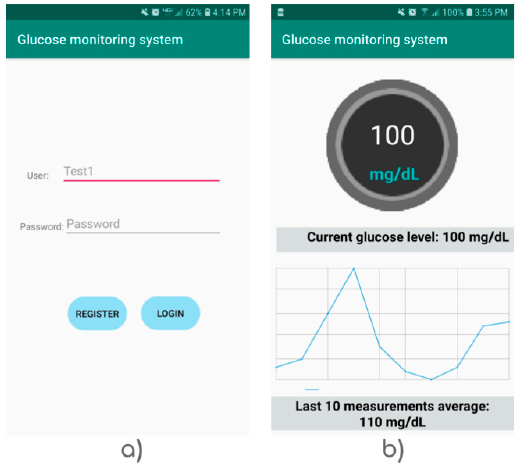
Figure 7. Example of mobile application screens ( a ) for login and ( b ) current glucose level.